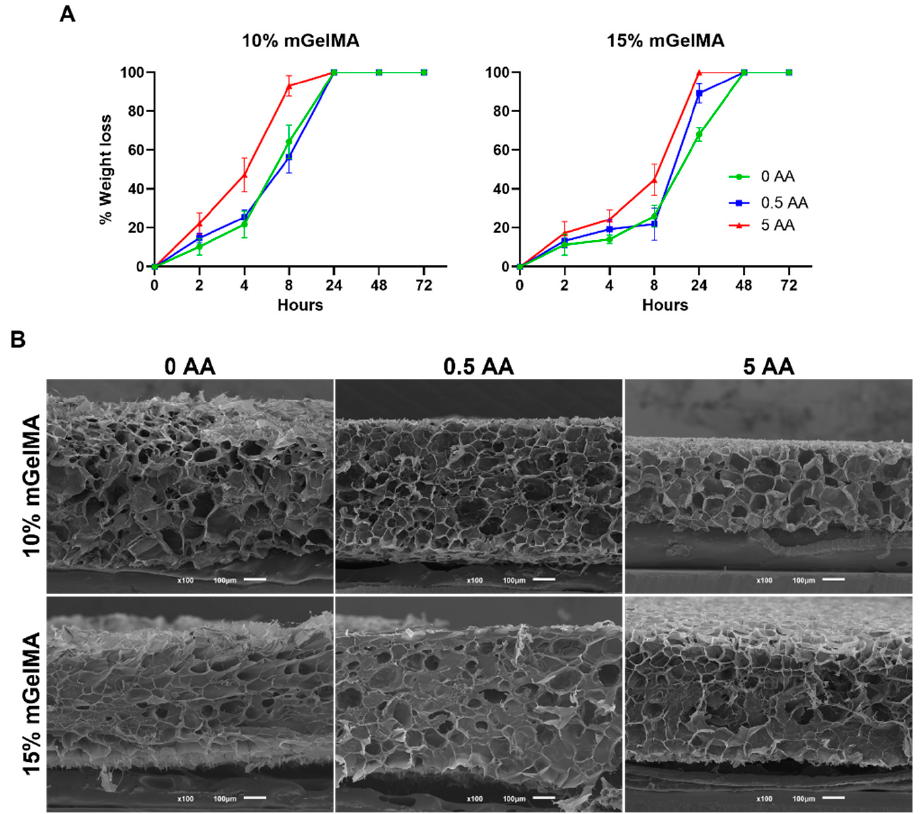
Figure 7. In vitro enzymatic degradation profile and resultant appearance of mGelMA hydrogels. ( A ) Weight loss of the mGelMA hydrogels as result of enzymatic degradation promoted by incubation in the collagenase-containing PBS at 37 °C. ( B ) SEM micrographs of cross-section of mGelMA hydrogels after 8 h of incubation with collagenase type II. Scale bars are 100 µm.